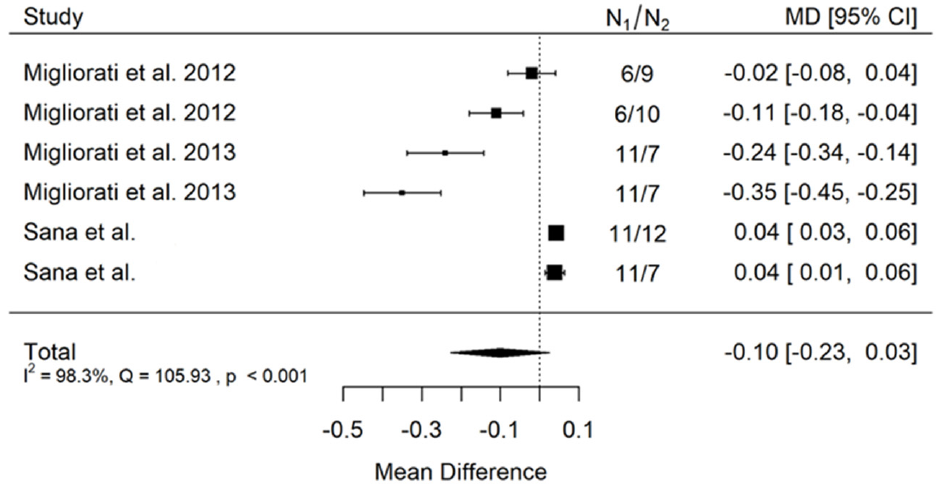
Figure 6. Forest plot for evalutaion of thread depth dimension infulence on pull-out strentght in artifical bone model studies [33,34,41].